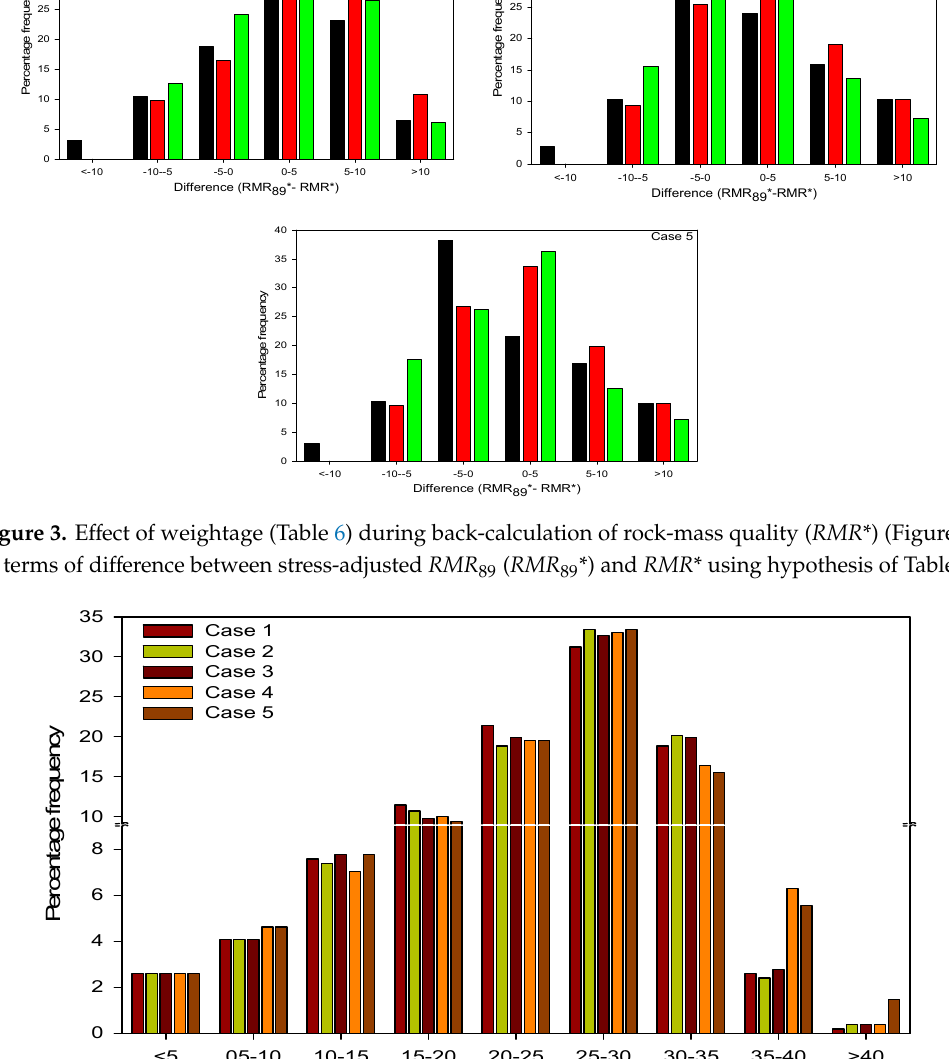
Figure 4. Percentage frequency of the calculated RMR 14 and back-calculated RMR ( RMR *) difference considering the five cases of Table 6.